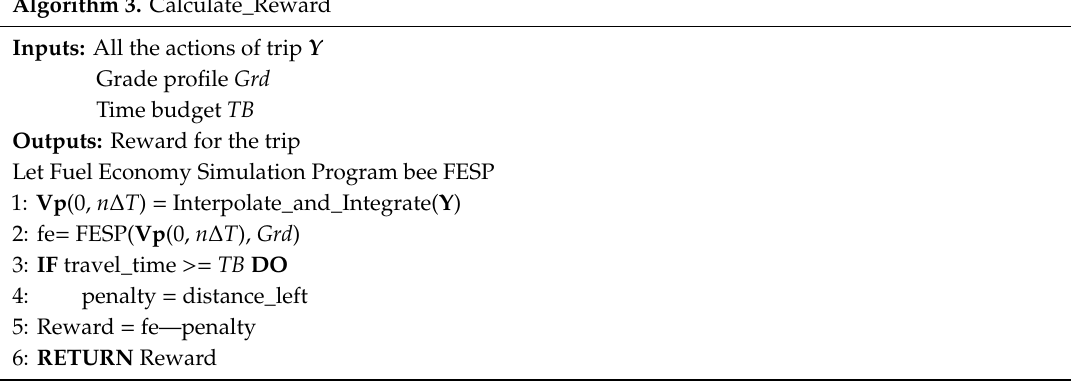
Algorithm 3. Calculate_Reward